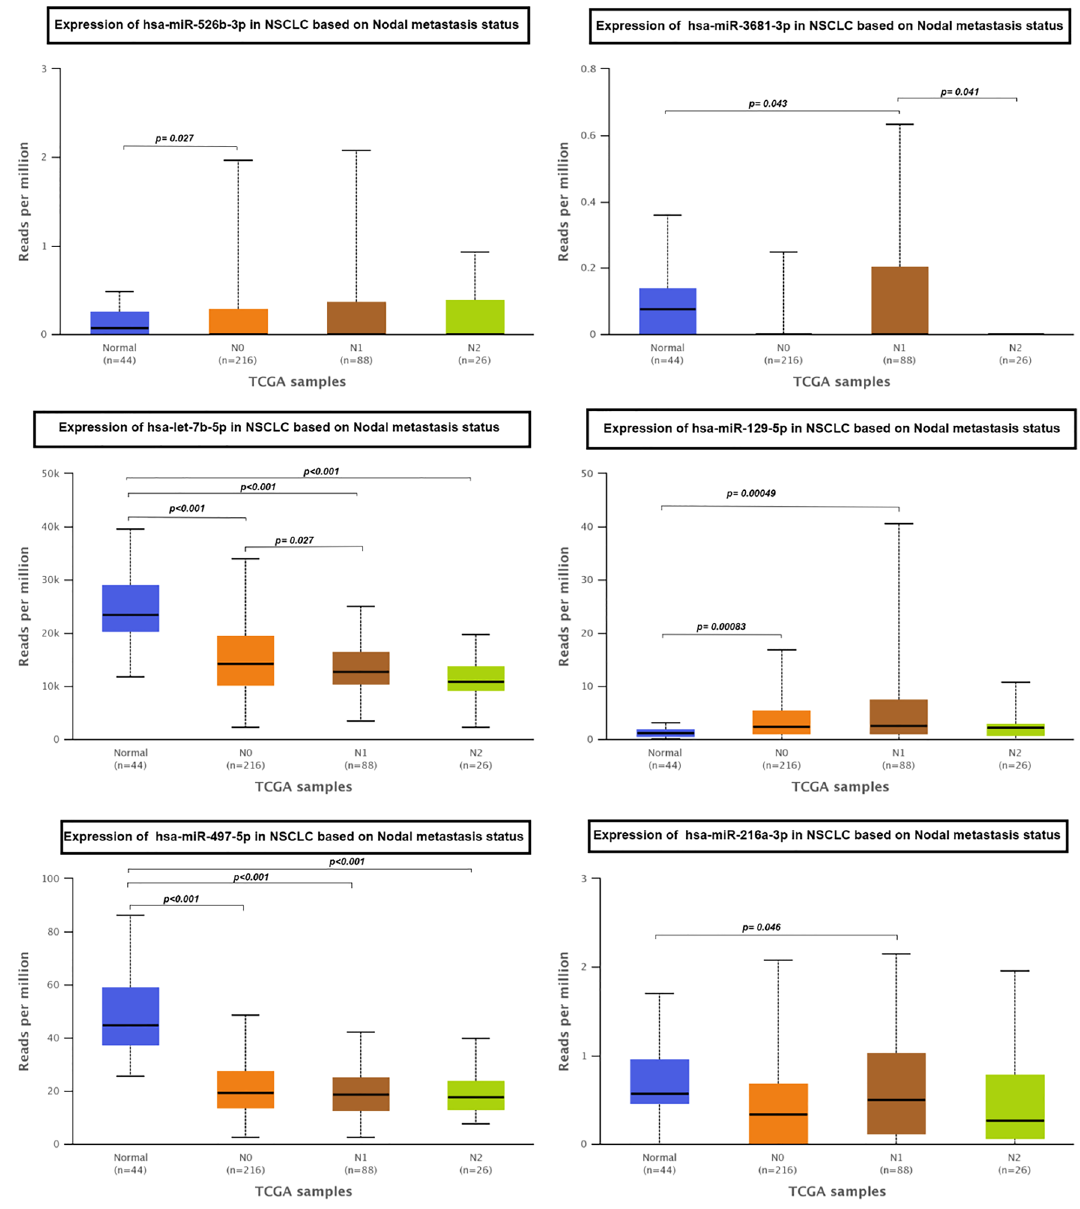
Figure 8. Expression levels of miRNA hub genes in normal and different stages of lymph node metastasis in LUSC